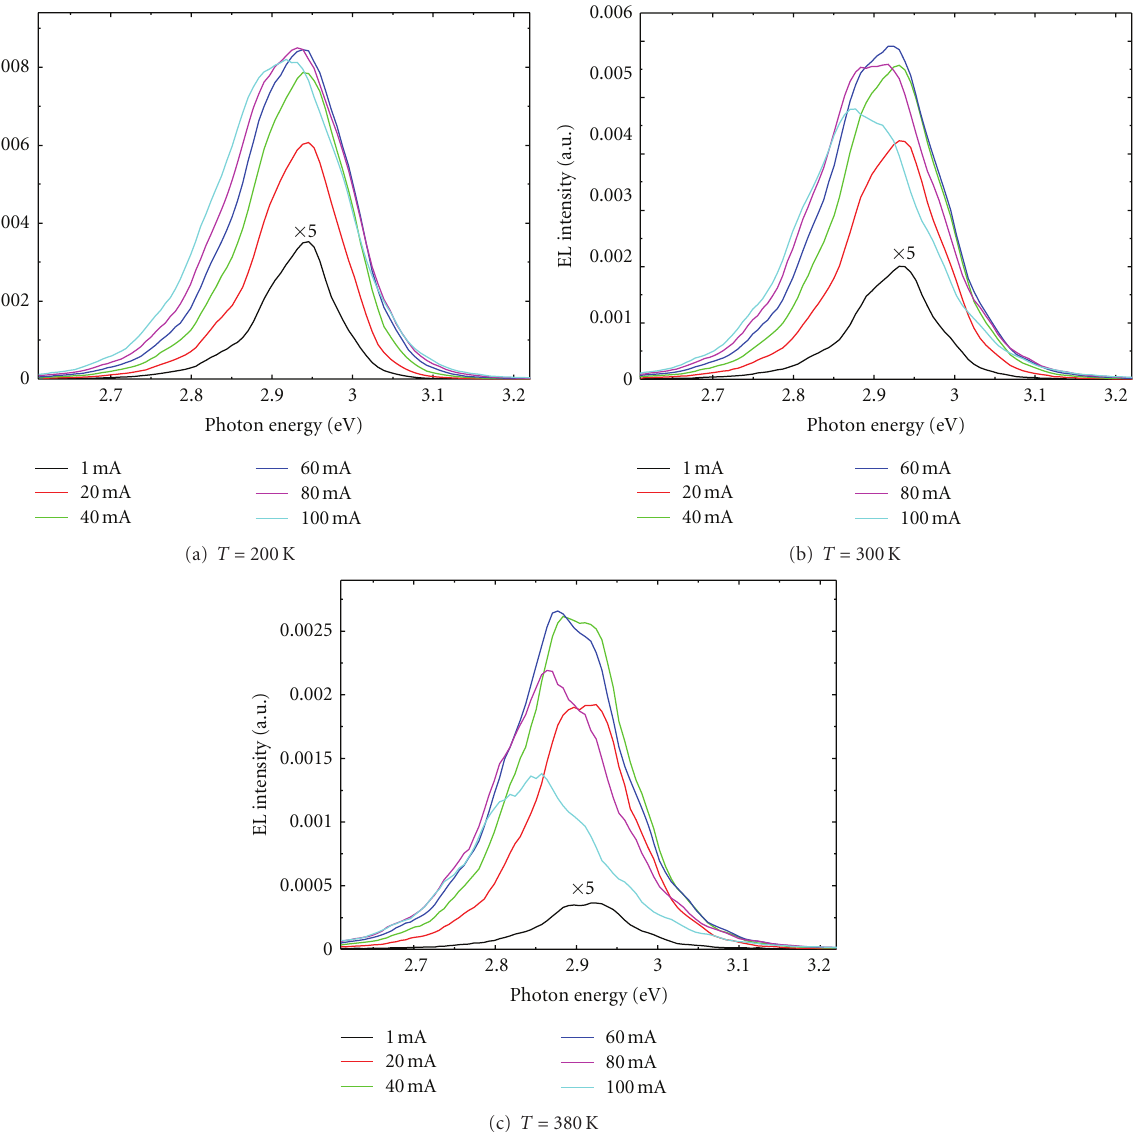
Figure 5: The EL spectra of sample with MQBs in the driving currents range 1 to 100 mA at temperature (a) 200 K, (b) 300K, and (c) 380 K.